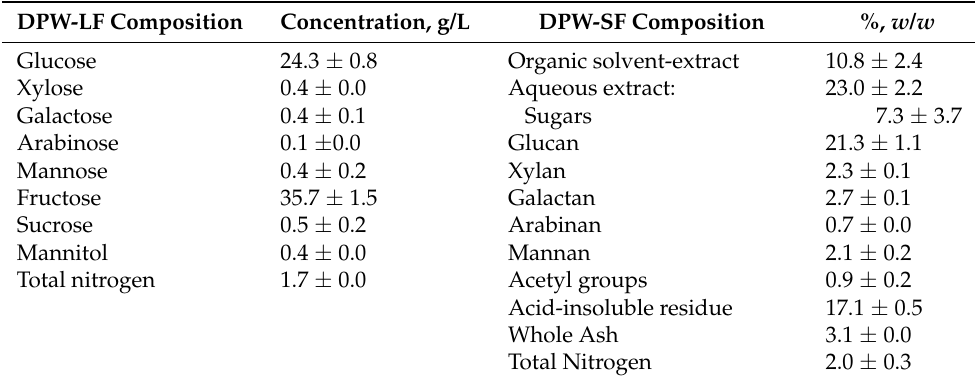
Table 4. DPW-LF and DFW-SF fraction